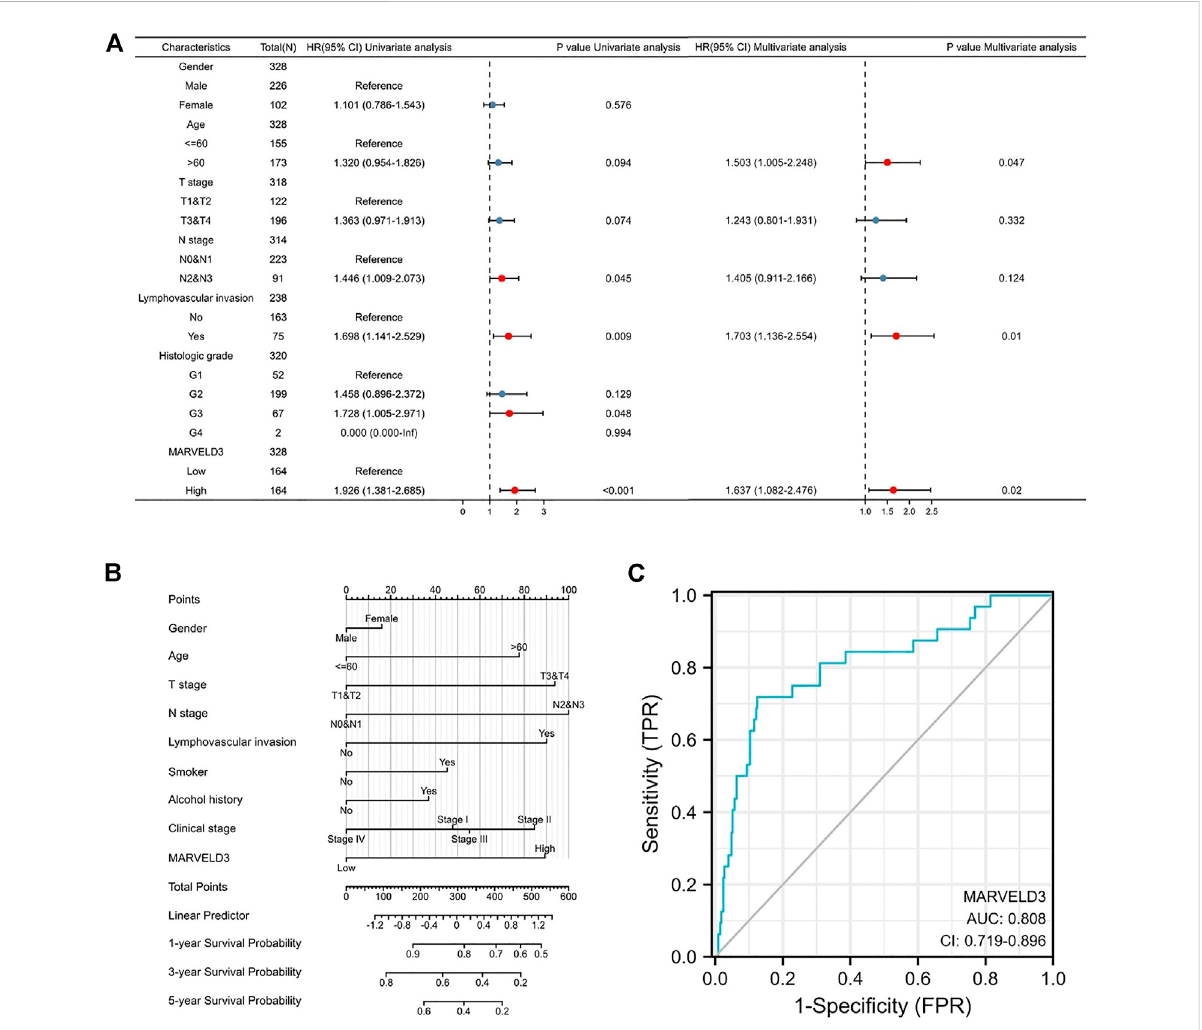
FIGURE 2 Diagnostic value of MARVELD3 in OSCC. (A) Univariate and multivariate Cox regression analyses. HR > 1 indicates disadvantageous factors, and HR < 1 indicates protective factors. Red dots are risk factors. (B) The nomograms were developed by integrating the MARVELD3 expression with key clinical characteristics. (C) The diagnostic value of MARVELD3 expression was evaluated using the ROC